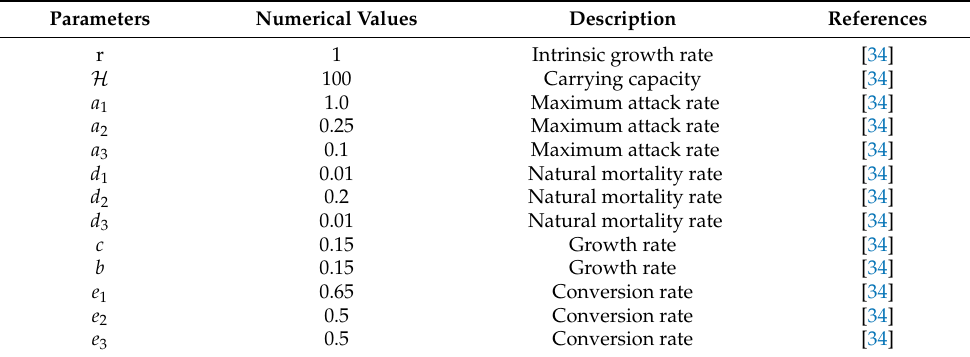
Table 1. Representation and numerical values of the assumed